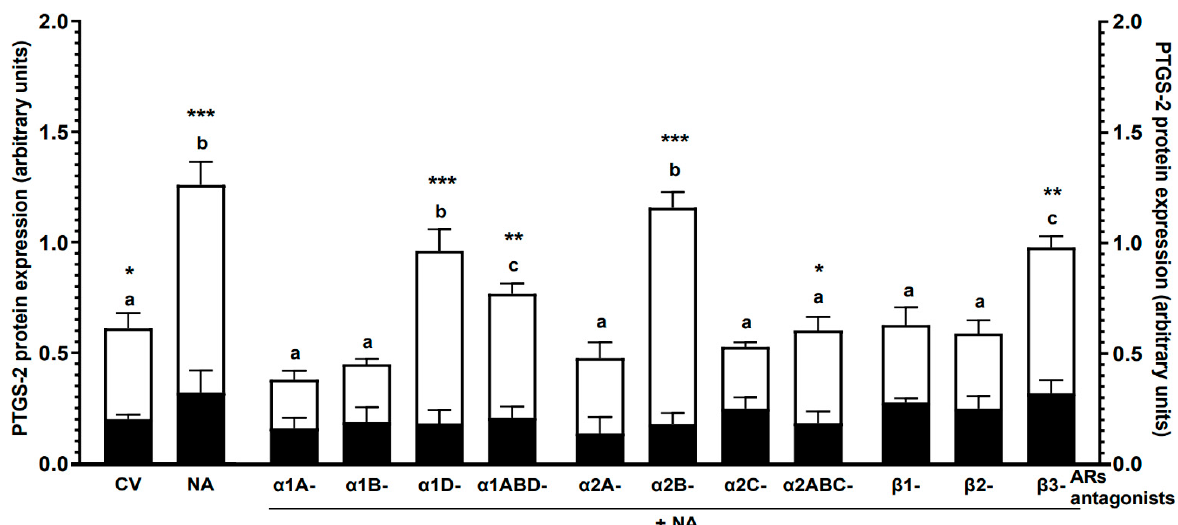
Figure 1. Effects of noradrenaline (NA, 10 − 5 ) alone or antagonists of α 1-, α 2- and β -ARs (10 − 4 M) with noradrenaline on the PTGS-2 protein expression in the pig endometrium of the CON (black bars) and E. coli (white bars) groups, estimated by the western blot method. Treatments were performed in triplicate for each of the five gilts in the individual groups. Values for PTGS-2 were normalized to GAPDH. The results are expressed as the mean ± sem. Blots with representative bands for each group are presented in Supplementary Figure S1. Different letters (a–c) indicate statistical differences ( p < 0.05–0.001) within each group for each subtype of α 1- or α 2-AR antagonists with noradrenaline or class of β -AR antagonists with noradrenaline and in relation to the control value (CV, untreated tissue) and noradrenaline action alone; *, **, *** indicate statistical differences ( p < 0.05–0.001) between groups for the same treatment.